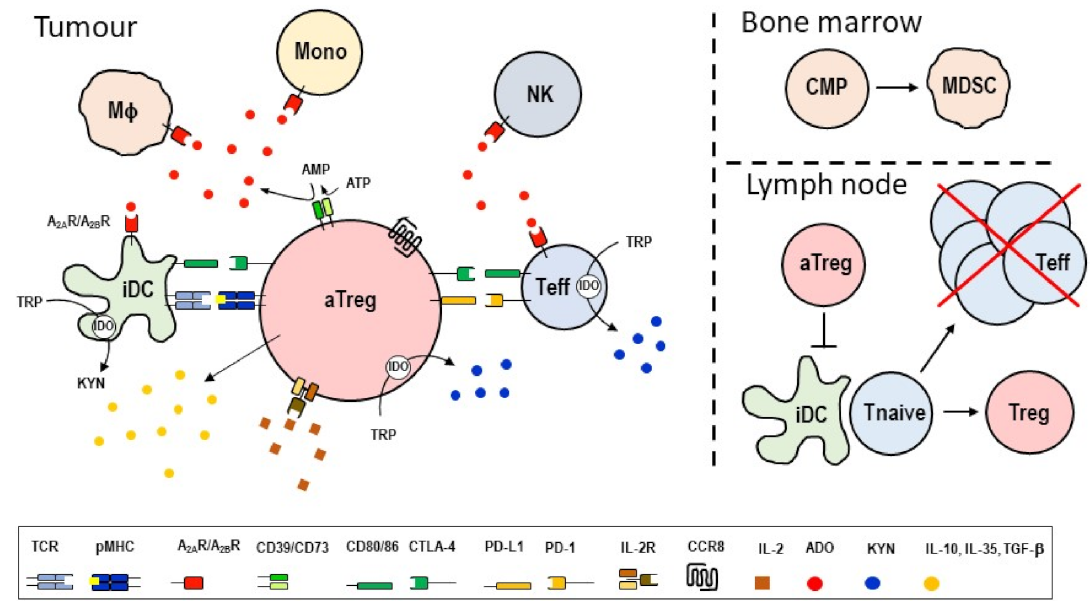
Figure 2. Tumor Treg cells elaborate diverse immunosuppressive functions affecting local (tumor- resident) and distal (lymphoid tissue-resident) immune cells. Tumor Treg cells also activate local tissue cells (not shown here). At the tumor site, activated Treg cells directly engage with conventional effector T cells and DCs. Enzymatic conversion of extracellular metabolites (ATP, tryptophan) leads to the production of inhibitors that suppress the function of effector T cells, NK cells, macrophages and monocytes. Changes to the cytokine milieu (depletion of IL-2 and production of TGF- β , IL-13 and IL-35) further augments the immunosuppressive function of Treg cells. In addition to local effects, both tumor Treg cells and their soluble products reach lymphoid tissues, including tumor draining LNs and bone marrow, where these factors amplify the immunosuppressive conditions by inhibiting anti-tumor effector T cells while generating additional Treg cells and myeloid-derived suppressor cells. aTreg, activated Treg cell; Teff, effector T cell; Tnaive, naïve T cells; iDC, inhibitory DC; NK, NK cell; M Φ , macrophage; CMP, common myeloid progenitor cell; Mono, monocyte; ADO, adenosine; IDO, indoleamine 2,3-dioxygenase, TRP, tryptophane; KYN,